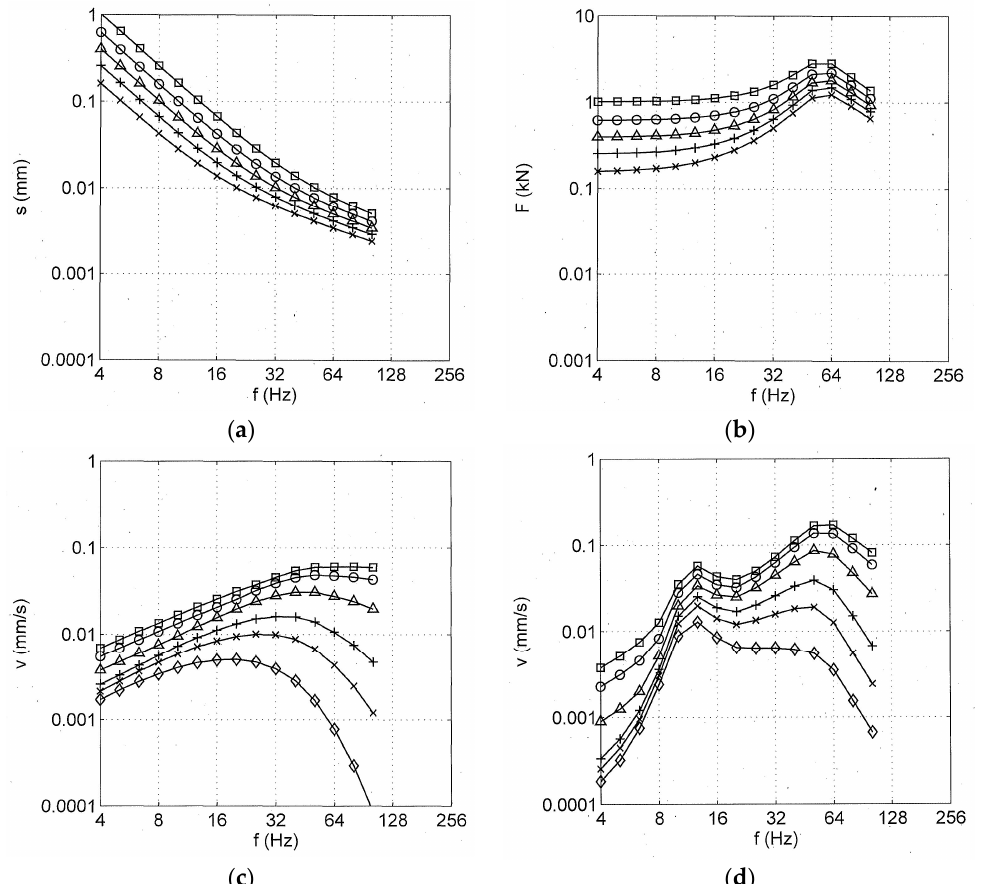
Figure 14. Vehicle and track irregularities ( a ) and wheel–rail forces ( b ) for different train speeds from 63 to 160 km/h; ground vibrations at different distances from 3–50 m for ( c ) a homogeneous soil ( v S 1 = 270 m/s D = 5%) with a constant force of 1 kN, ( d ) for a layered soil ( v S 2 = 1000 m/s, h =10 m) with the force from ( b ), v T = 160 km/h.